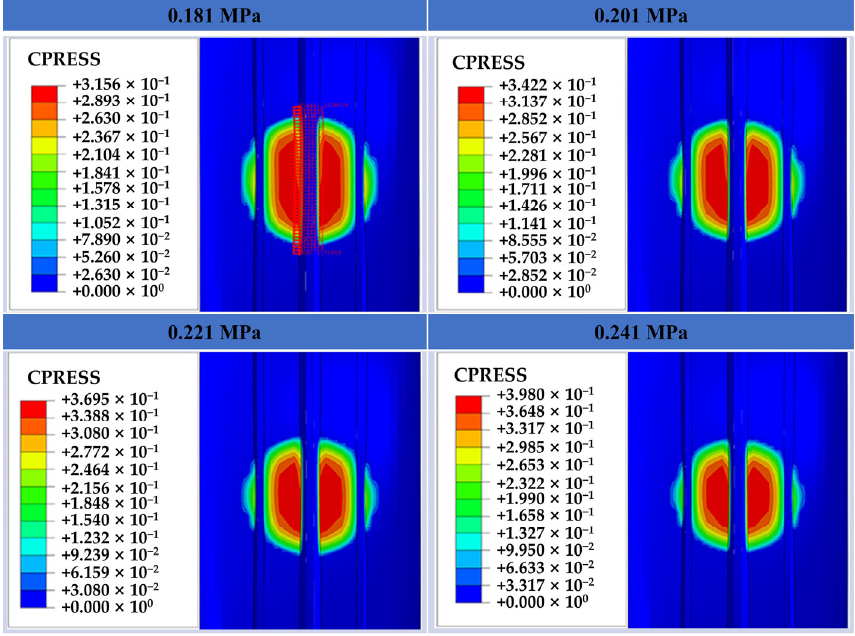
Figure 9. Contour map of tire contact pressure under different inflation pressures.